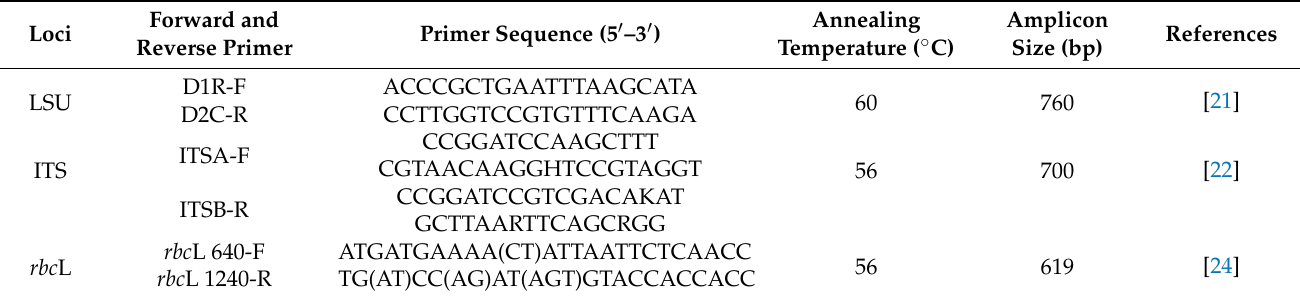
Table A4. Primers for LSU, ITS1-5.8S-ITS2 and rbc L DNA